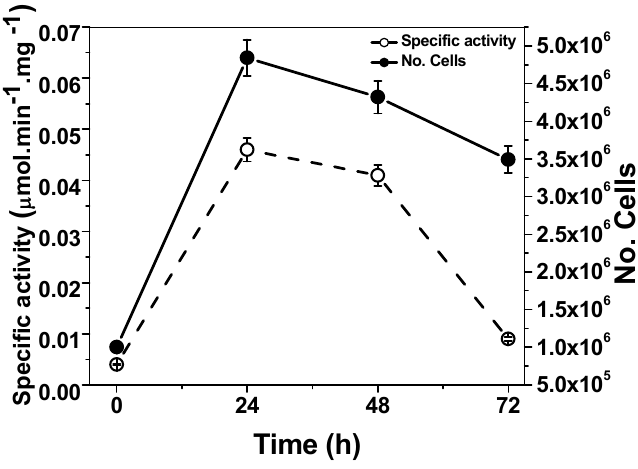
Figure 1. Kinetics of cell growth (●) and G6PD::6PGL enzyme activity (  ) from the G. lamblia trophozoites. The activity for the 6PGL was not detected. The figures represent the average of three independent